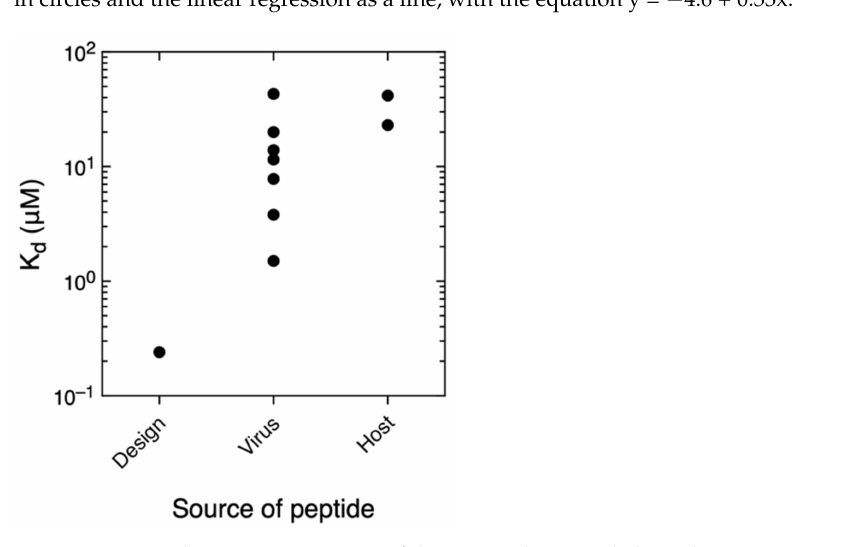
Figure 5. Logarithmic representation of the K d vs. the peptide ligand source in our